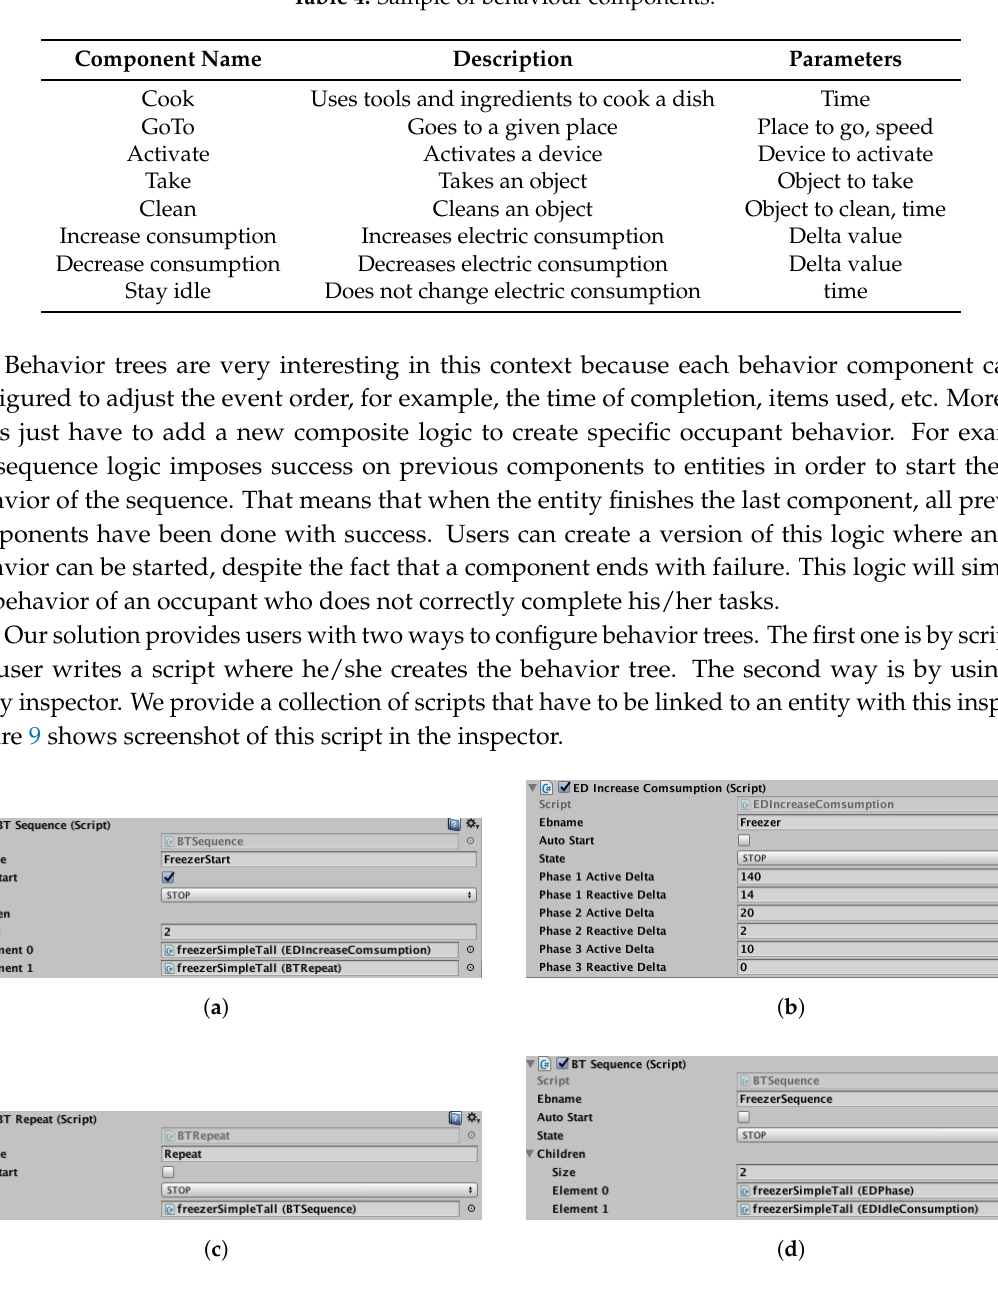
Table 4. Sample of behaviour components.